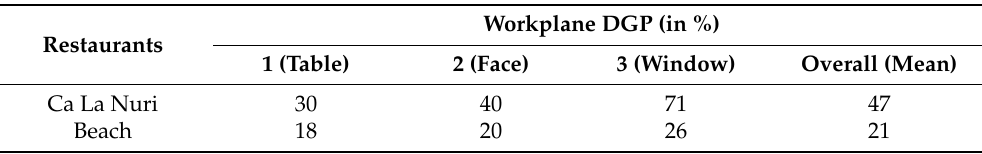
Table 3. Three local workplanes (table, face, and window) and the mean Daylight Glare Probability (DGP) index according to the overall workplanes.